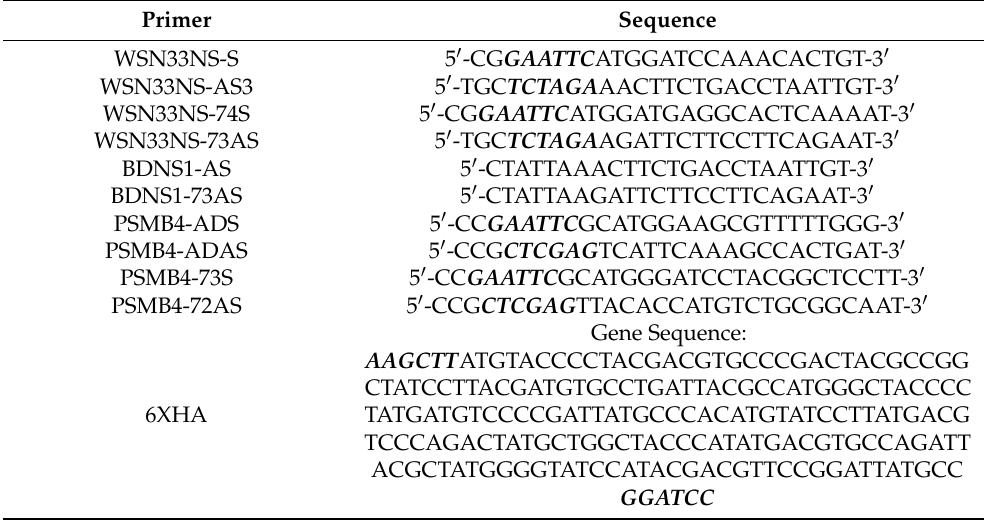
Table 1. PCR primers used for plasmid